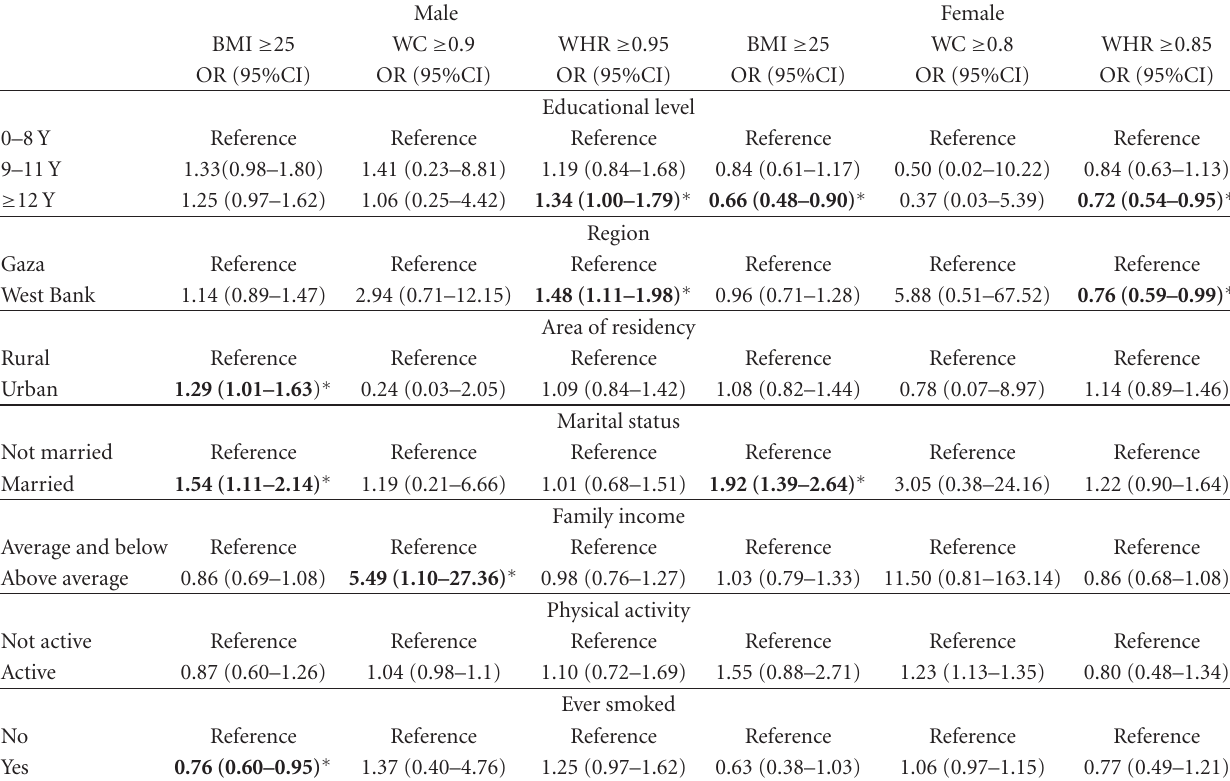
Table 4: Age-adjusted odd ratios (95% confidence interval) for being overweight or obese based on body mass index, waist circumference, and waist-to-hip ratio, with demographic and lifestyle factors in Palestinian adults by